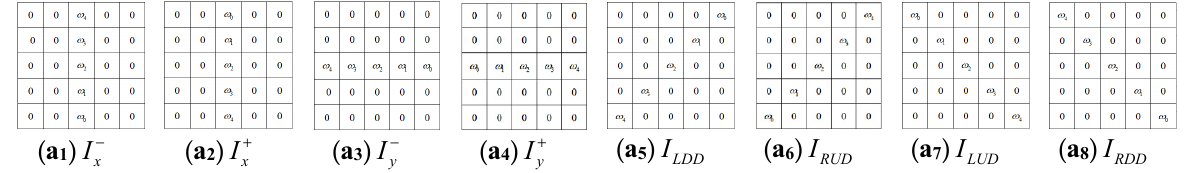
Figure 1. Fractional-order mask operator: ( a 1 -a 2 ) are the positive and negative x-axis directions re- spectively; ( a 3 -a 4 ) are the positive and negative y-axis directions respectively; ( a 5 -a 6 ) are the lower left and upper right diagonals respectively, ( a 7 -a 8 ) are the upper left and lower right diagonals re- spectively.